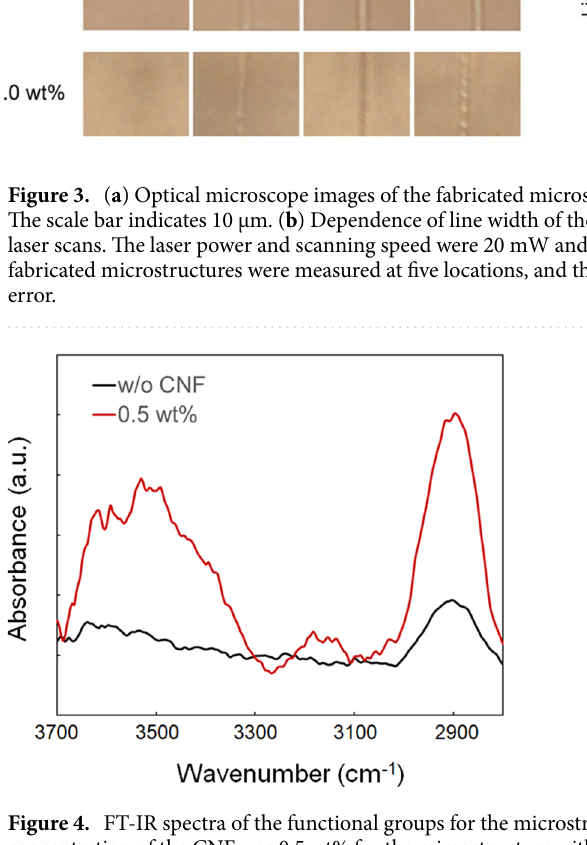
Figure 3 depicts the optical microscope images and the line widths of the fabricated microstructures with different numbers of laser scans. The laser power and scanning speed were 20 mW and 125 µm/s, respectively.